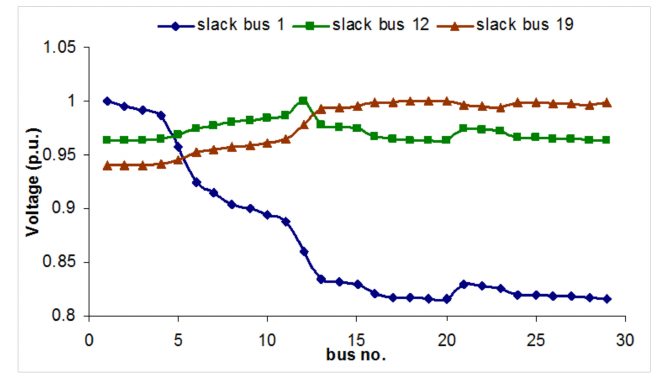
Figure 15. Variation of losses with location of PV system for a load of 10